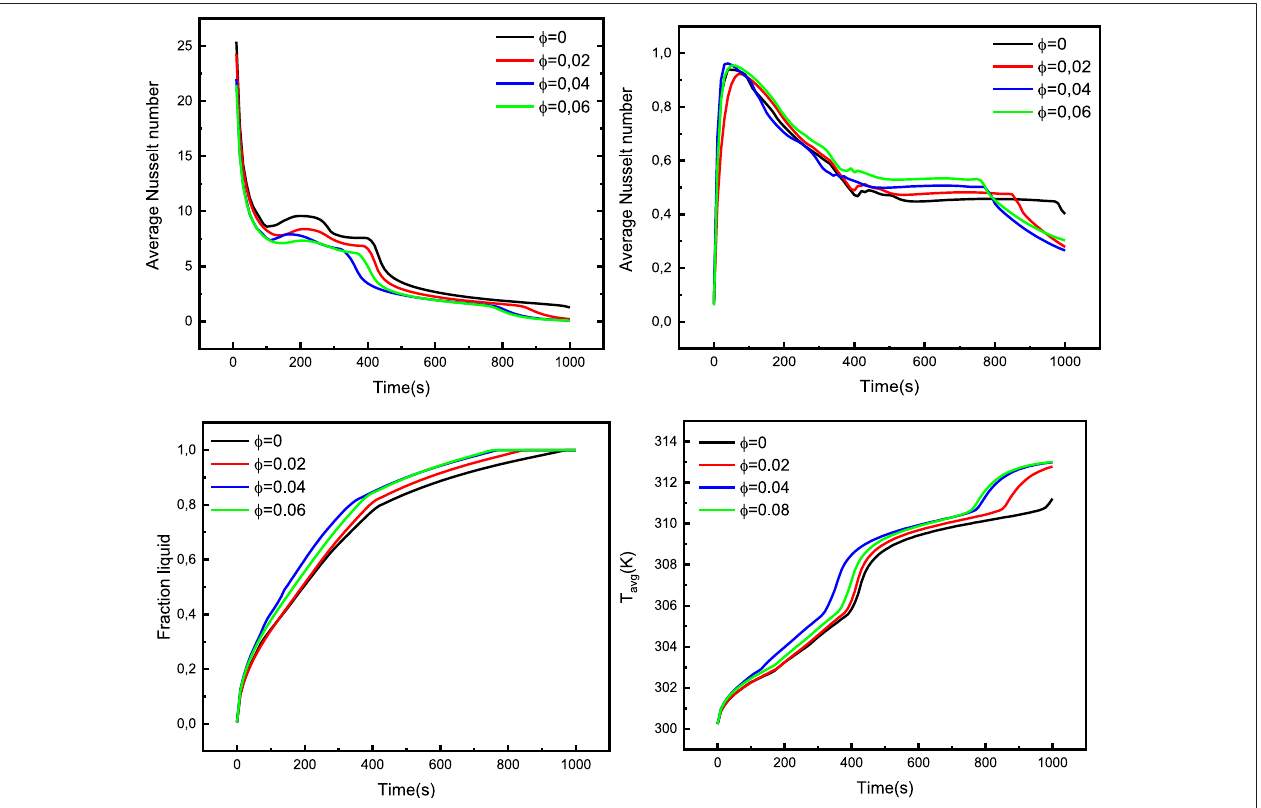
FIGURE 8 | The impact of nanoparticles concentration on molten liquid, Average Nusselt number (Nu avg ) and Average Nusselt number Average Nusselt number (Be avg)